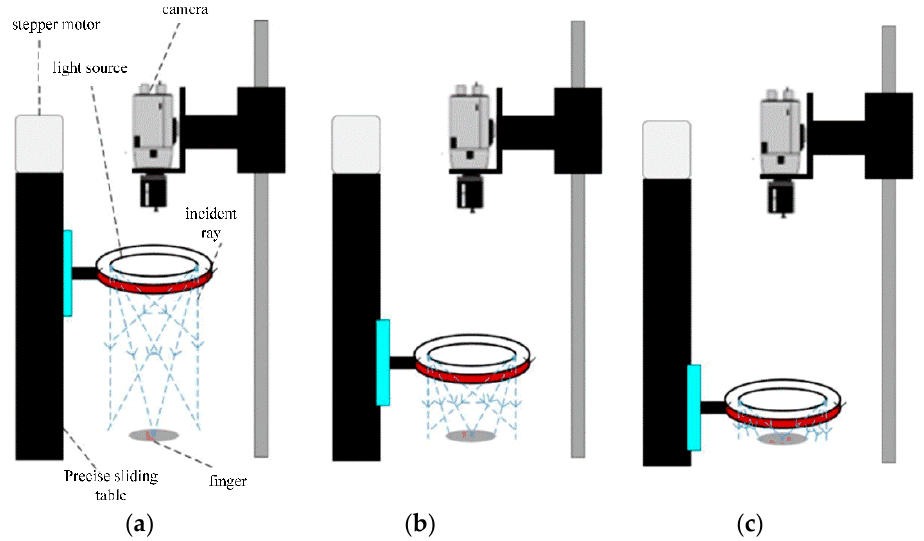
Figure 5. Image-acquisition method based on the active multi-angle light-source-detection method.